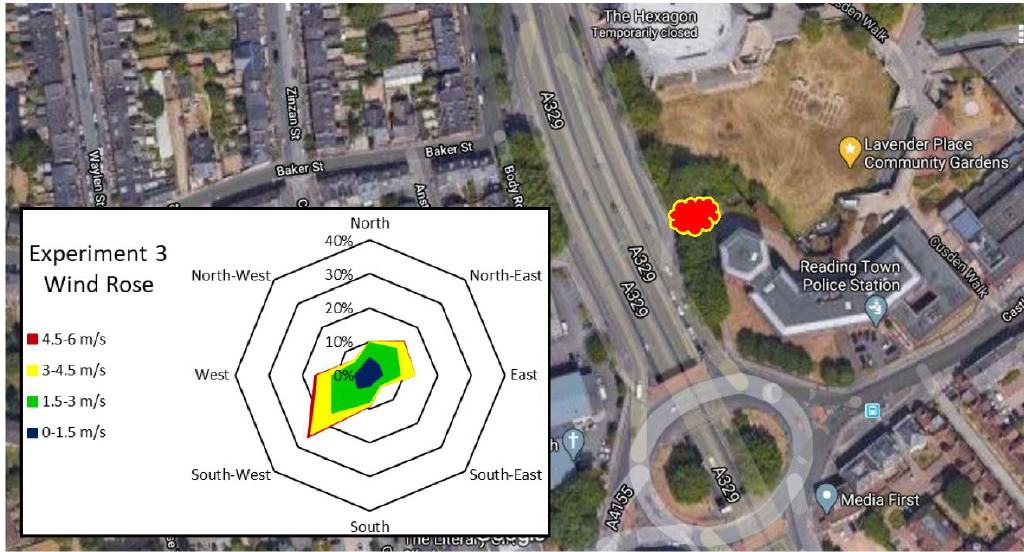
Figure 3. Location of the major-road sampling site for Experiment 3, and corresponding wind rose indicating prevailing wind conditions a month prior to sampling. This site corresponds to red location marker 2 in Figure 1.